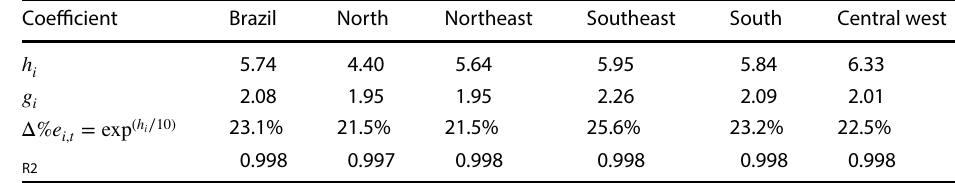
Table 1 Estimated coefficients for Eq. 3 and